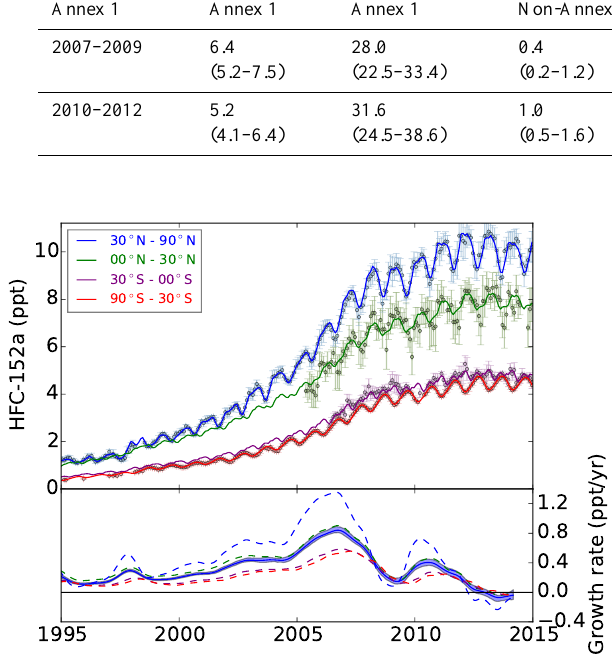
Figure 6. Top panel: AGAGE 12-box model mole fractions (solid line) for the two NH (30–90 ◦ N, MHD, and THD and 00–30 ◦ N, RGP) and the two SH (30–00 ◦ S, SMO and 90–30 ◦ S, CGO) latitu- dinal bands The points show the semi-hemispheric monthly mean observations from the five AGAGE stations used in the inversion (MHD, THD, RPB, SMO, CGO). Lower panel: HFC-152a semi- hemisphere annualized growth rates are shown as dashed lines (see Rigby et al., 2014 for smoothing method), with the solid blue line and shading showing the global mean and its uncertainty.